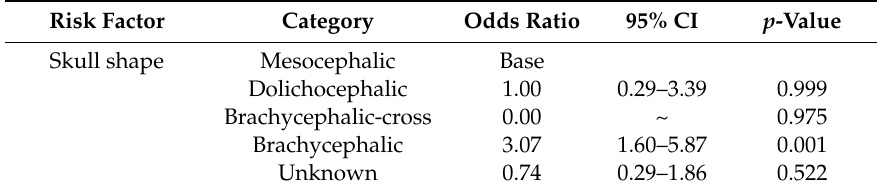
Table A4. Results for variables that individually replaced the breed type variable in the final multivariable logistic regression model (with sex / neuter) to evaluate risk factors associated with vehicular heat related illness in dogs under primary veterinary care in the VetCompass